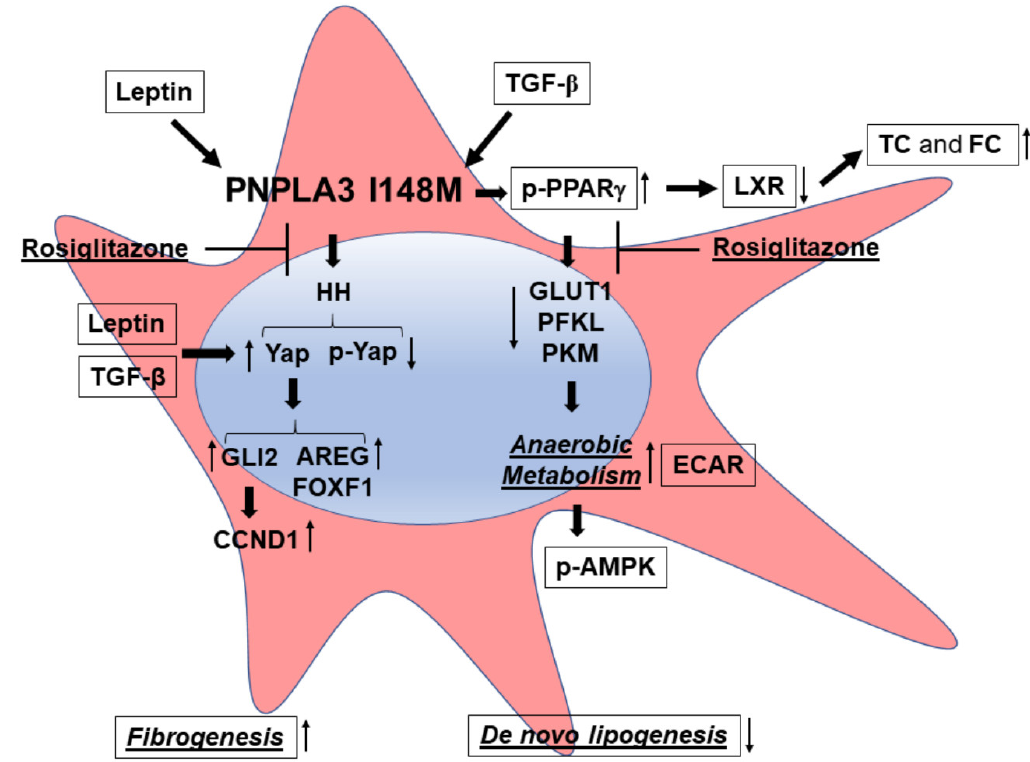
Figure 6. PNPLA3 I148M promotes activation of HH signaling and its downstream target Yap. Summary scheme representing the major molecular steps characterizing the phenotype of I148M HSCs. The presence of the PNPLA3 genetic variant leads to disturbed PPAR γ and LXR signaling (accumulation of total cholesterol = TC and free cholesterol = FC), resulting in activation of Hedgehog (HH) and Yap signaling and an increase in anaerobic metabolism (higher ECAR and diminished expression of GLUT1, PFKL, PKM). Both TGF- β and Leptin induce expression of Yap, as a target of the HH pathway, and its downstream e ff ectors (Vimentin, FOXF1, AREG, CCND1). Inhibition of Yap by Rosiglitazone leads to decreased Yap transcriptional activity in HSCs carrying PNPLA3